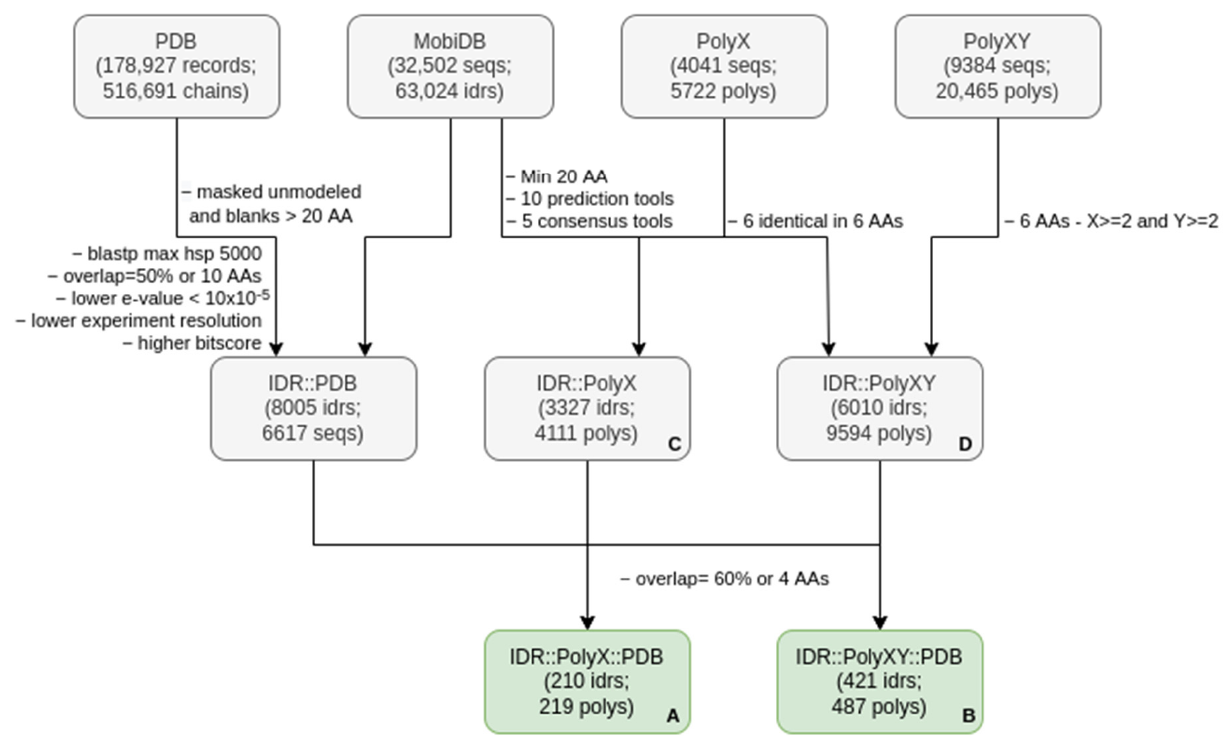
Figure 1. Description of the process to create the target dataset . The first number in each box refers to items from the original set from where the second items were extracted, e.g., IDRs from sequences or polyXYs from IDRs, with the exception of the PDB box, which accounts for PDB records and chains. See the Materials and Methods for details. The names used in parentheses indicate: seq, sequences; poly, polyXs or polyXYs; and idr, IDRs. ( A ) Final set of IDRs overlapping PDB sequences that contain polyXs; ( B ) Final set of IDRs overlapping PDB sequences that contain polyXYs; ( C ) Number of IDRs that contain polyXs independently of overlaps with PDB sequences and; ( D ) Number of IDRs that contain polyXYs, also independently of overlaps with PDB